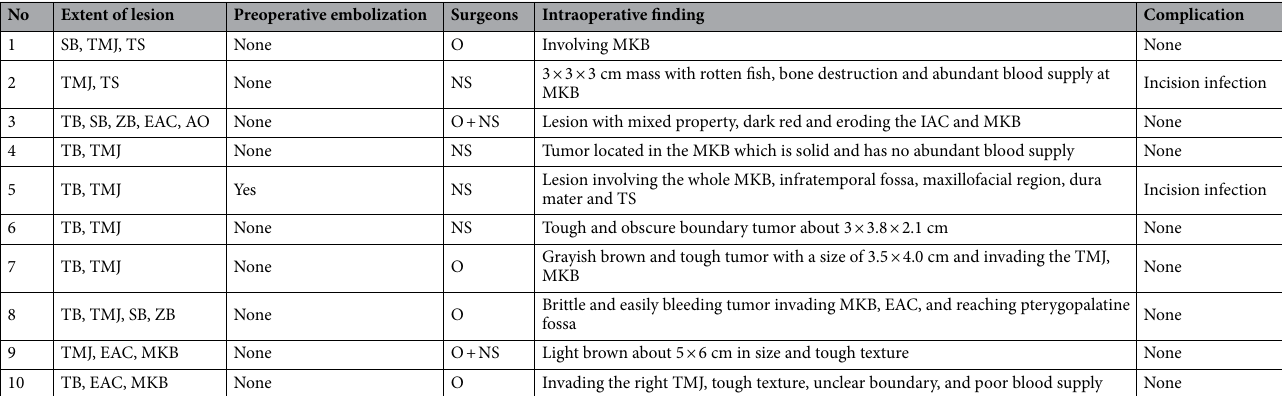
Table 2. Operative information of 10 Patients of PVNS in the TMJ with the skull base extension. SB sphenoid body, TS temporal squama, TB temporal bone, ZB zygomatic bone, EAC external auditory canal, AO Auditory ossicles, MKB middle skull base, IAC internal auditory canal, NS Neurosurgeon, O